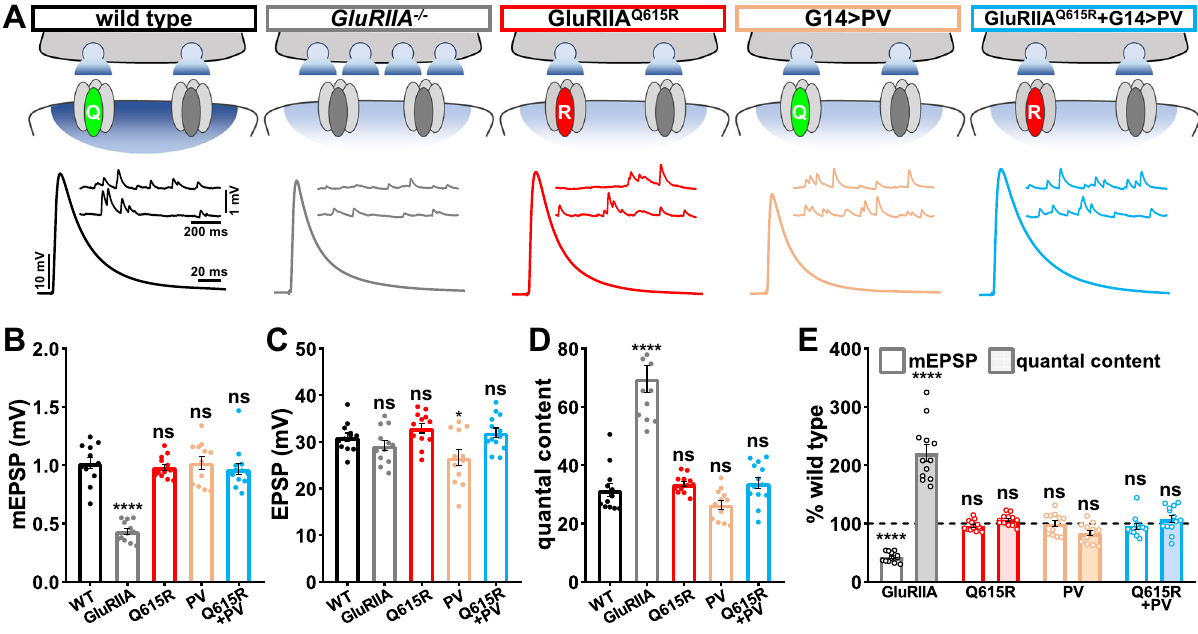
Fig. 4 | Reductions in postsynaptic Ca 2+ levels do not induce PHP expression. A Schematic depicting genetic manipulations that reduce postsynaptic Ca 2+ levels atthe Drosophila NMJ.Representativeelectrophysiologicaltracesareshownbelow each indicated genotype. B – D Quanti fi cation of average mEPSP amplitude ( B